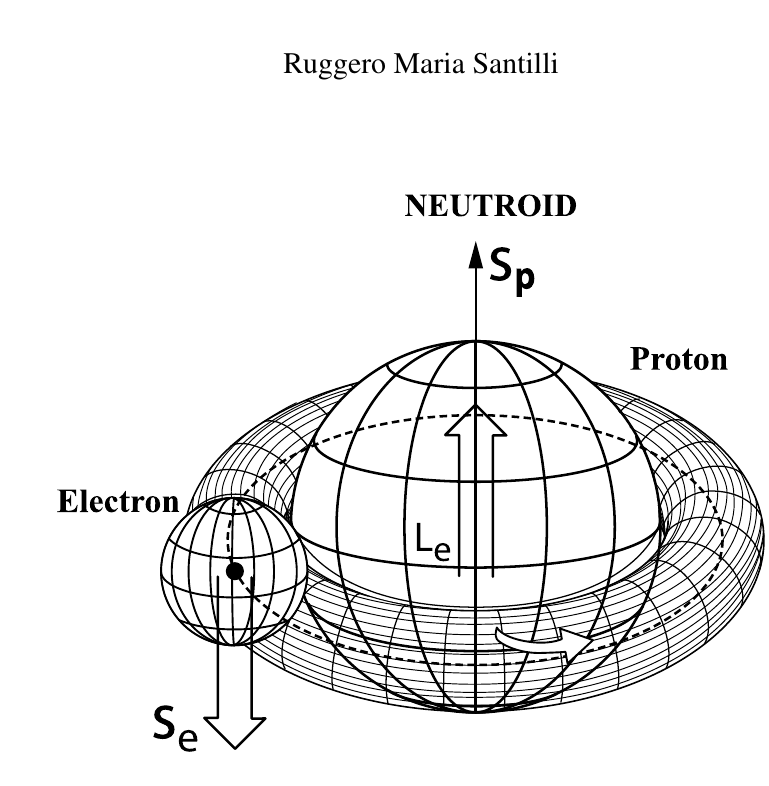
Figure 10: A conceptual rendering of the structure of a particle called the neutroid , Eq. (61), with spin J = 1 , charge radius R = 10 − 13 cm , mass essen- ˜ n = ( e − , p + ) hm tially that of the proton and mean-life of the order of 5 s which has been undetected in all experiments to date [I-90]-[I-95] by neutron detectors, yet has caused nuclear transmu- tations typical of neutron irradiation. The bound state is created by the extremely strong, r − p Coulomb attraction which is of the order of 10 24 N plus weak contact interactions implying ignorable mutations of the electron and the proton. The e − p singlet coupling and the orbital motion in the ground state imply the spin J = 1 explaining the lack of de- tection of neutroids by neutron detectors. Note that the neutroid is impossible for quantum